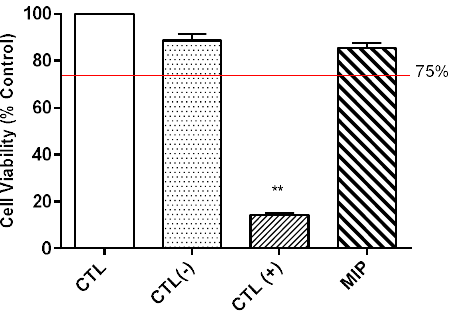
Figure 4. Biocompatibility of mesoporous iron particles. CTL: control. CTL( − ): negative control, Aluminum oxide. CTL( + ): positive control, zinc diethyldithiocarbamate. MIP: mesoporous iron particles. Compared with CTL group, the cell viability more than 75% (Red line) indicated not potential toxicity. ** p < 0.01 compared with control group, n = 6.